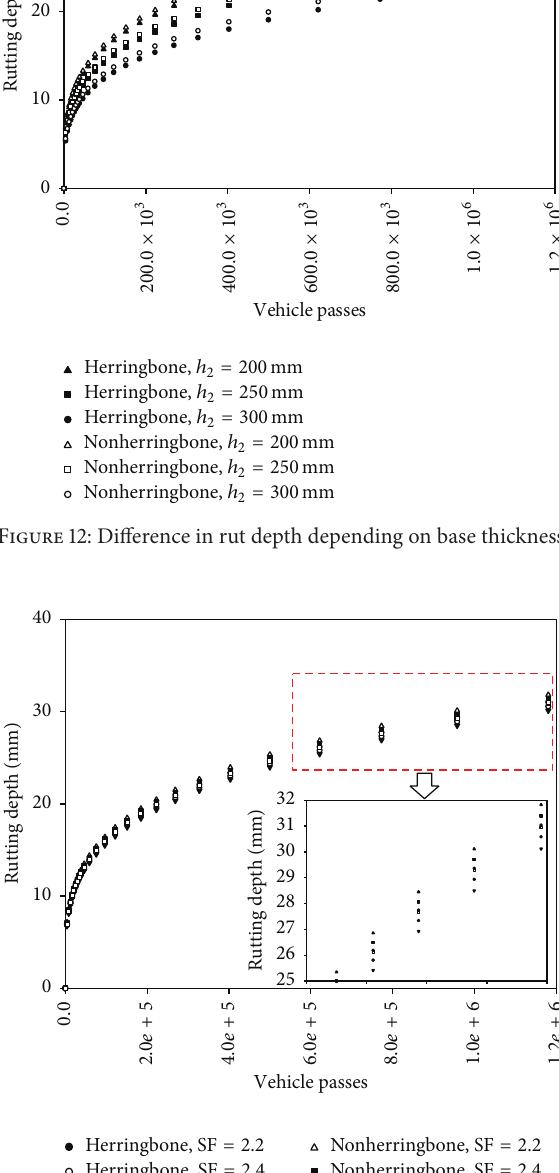
insignificant; rut depth was found to be affected more by the construction pattern than by block shape. These findings are similar to those from a field test [16]. It is inconclusive, however, that construction pattern is the only determinant in load distribution effect. Because CBP performs as a com- plex interlocking mechanism of horizontal, vertical,